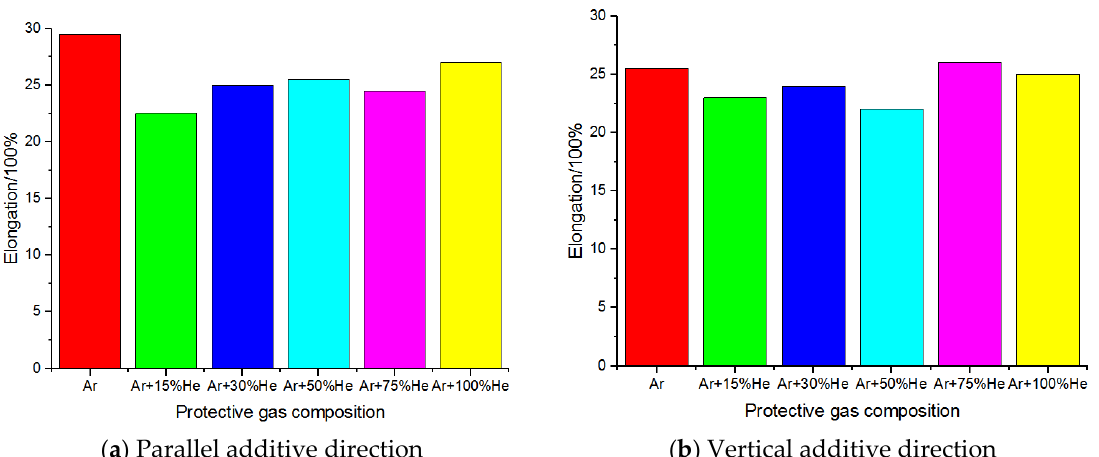
Figure 14. Sample elongation under different protective gas compositions.